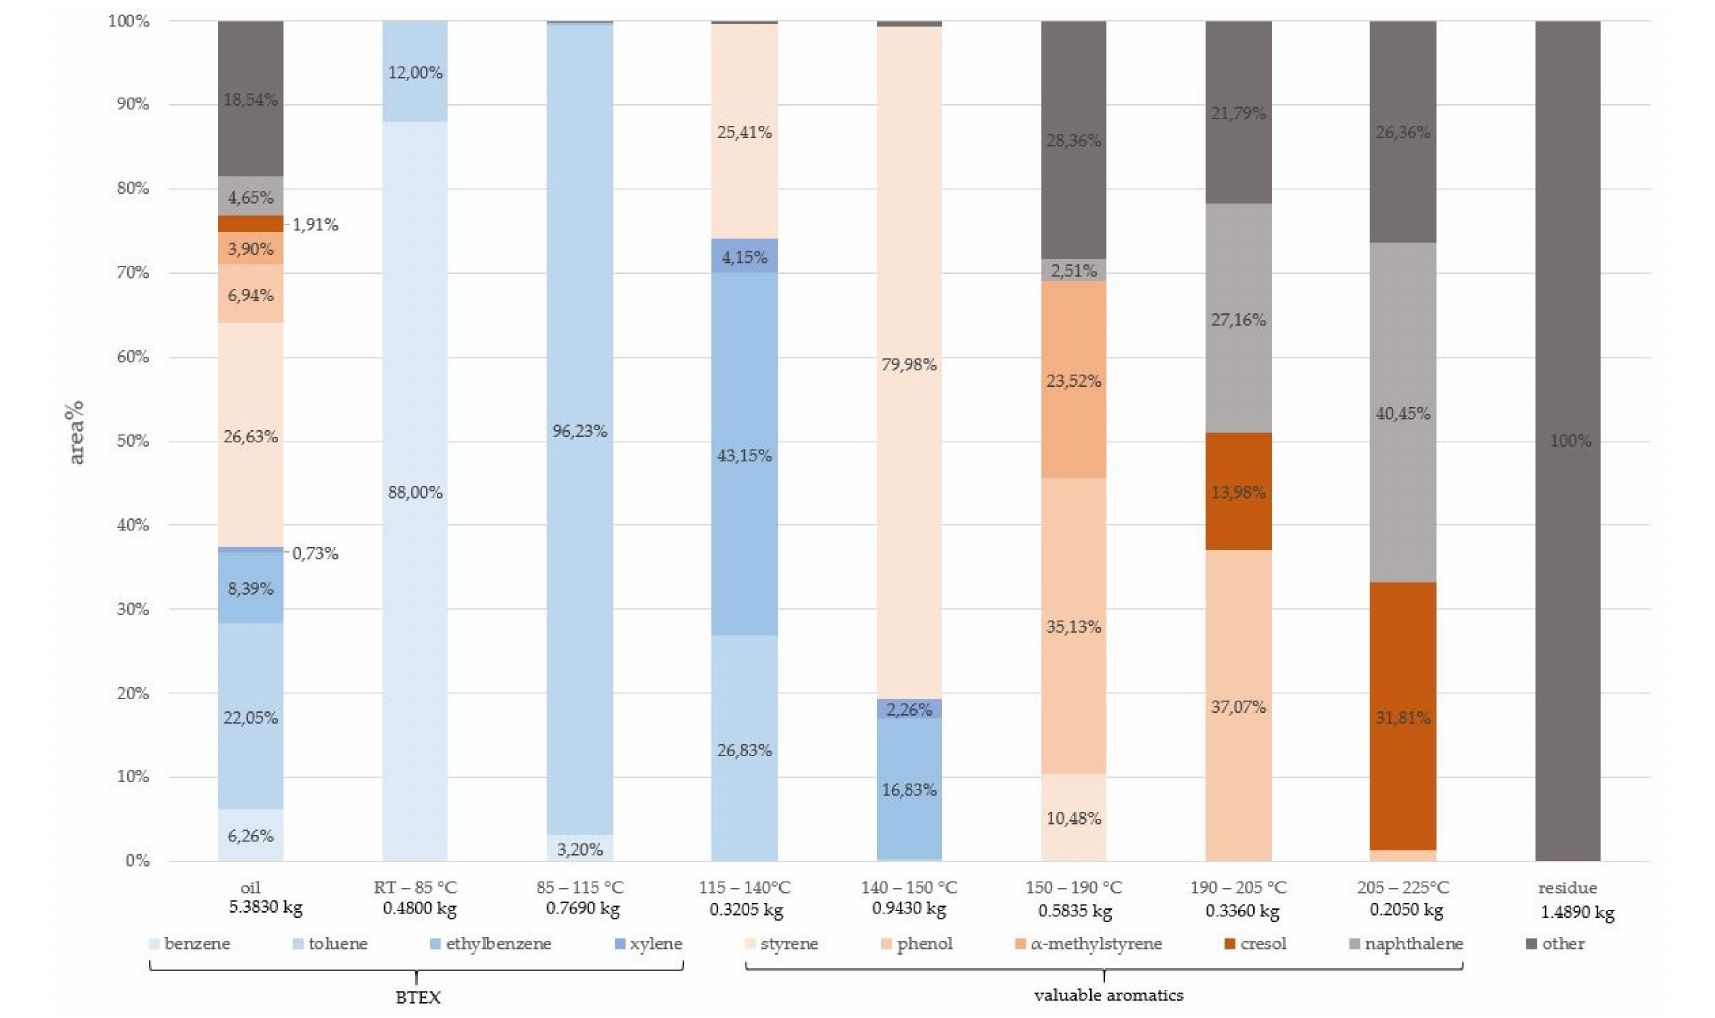
Figure 2. Composition of oil and distillate